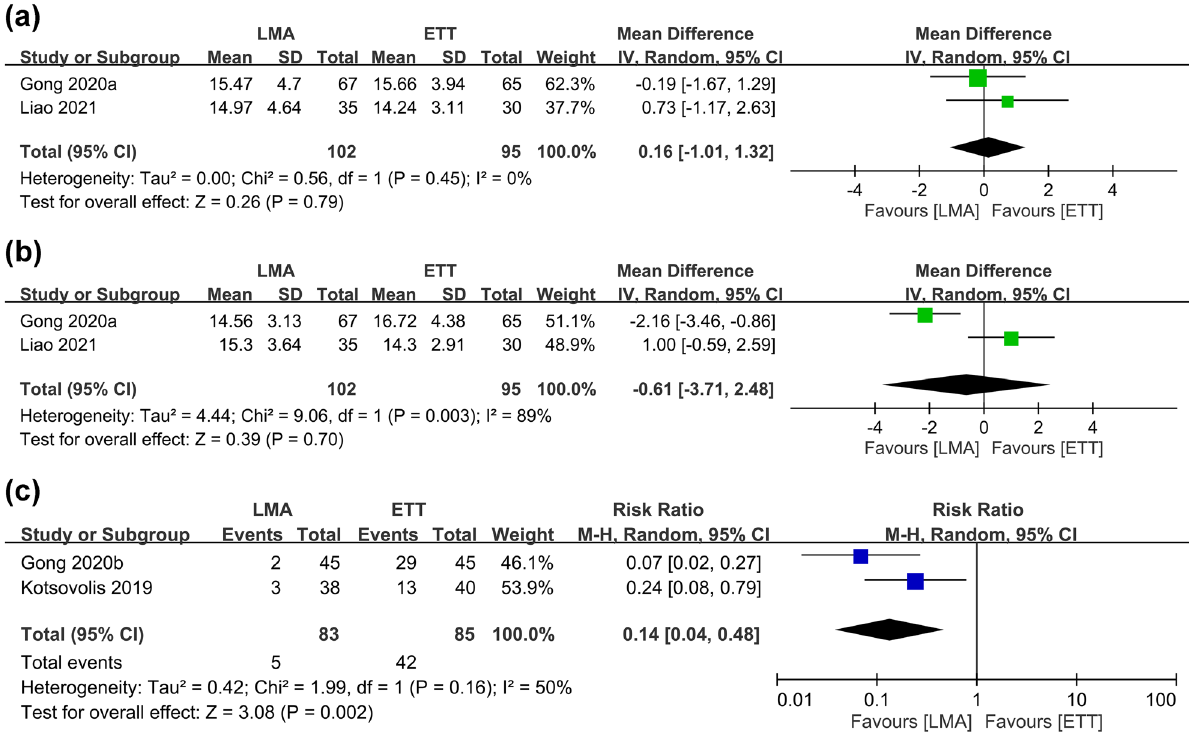
Figure 8. Forest plot comparing the differences in airway pressure at ( a ) 30 min and ( b ) 60 min after surgical incision as well as ( c ) risk of emergence cough between laryngeal mask airway (LMA) and endotracheal tube (ETT) groups. CI confidence interval, IV inverse variance, Std standardized, M–H